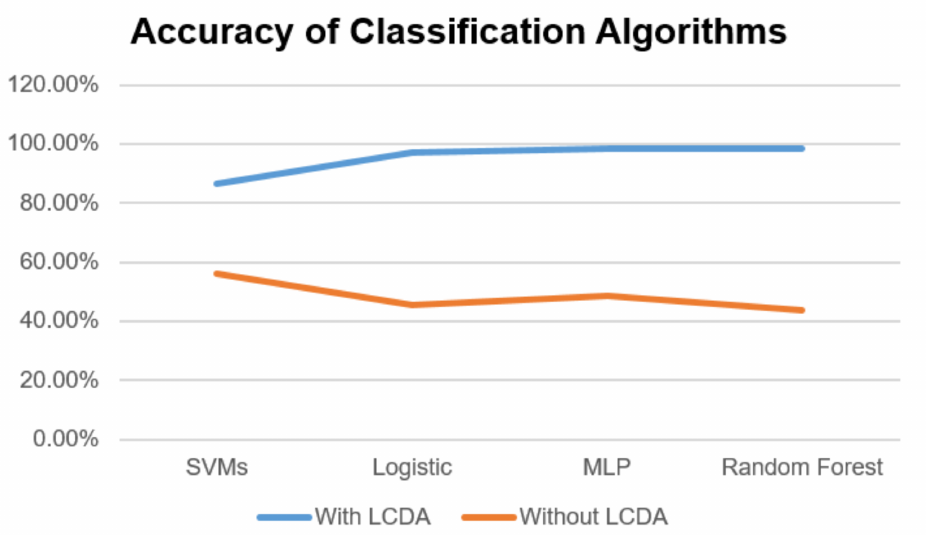
The accuracies are 86.36%, 96.97%, 98.48%, and 98.48% using SVMs, logistic, and MLP, random forest, respectively. The MLP and random forests achieve the highest level of accuracy (Figure 6).